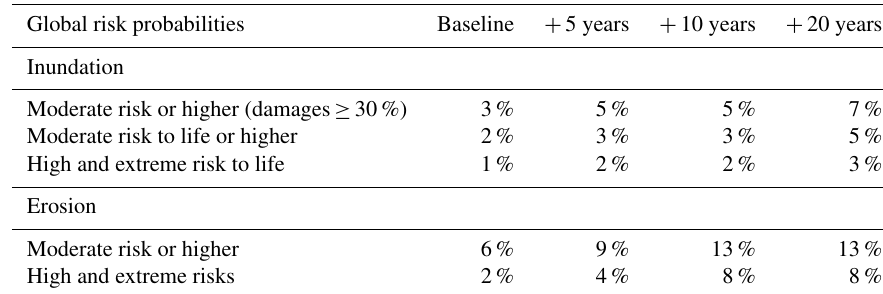
Table 6. Global risk probabilities for different risk levels under the different scenarios. Note that global risk probabilities account for the variability in the source (storm climate) and the spatial distribution of impacts on the receptors.